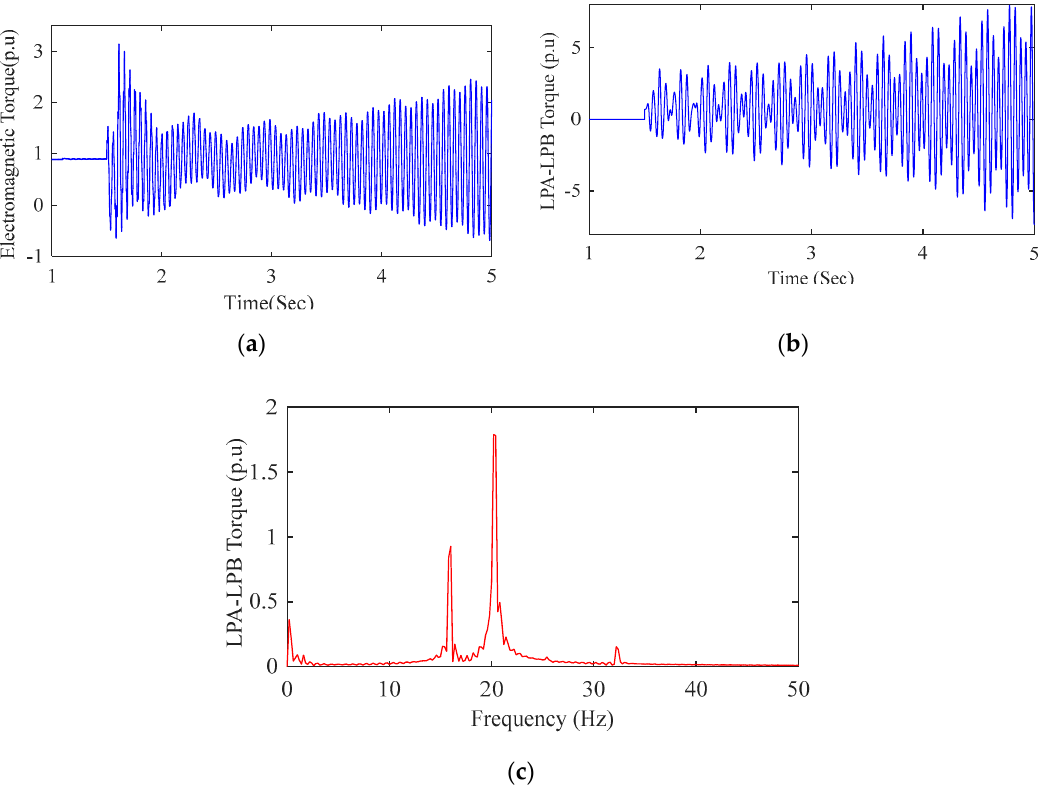
Figure 3. System response in three phase short circuit fault. ( a ) Generator electromagnetic torque. ( b ) LPA-LPB torque. ( c ) Fast Fourier transform (FFT) of the LPA-LPB torque.